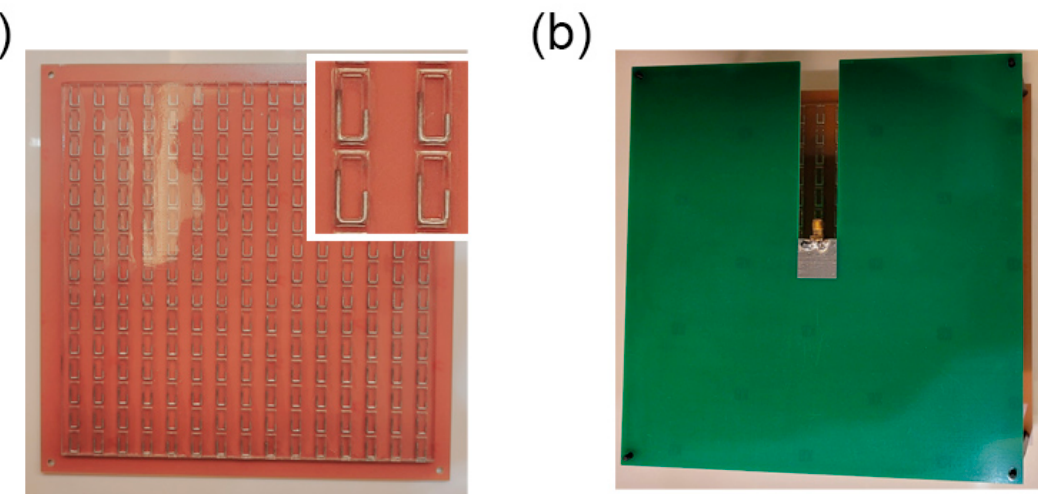
Figure 4. The fabricated metasurface antenna sample photograph. ( a ) Photograph of the liquid-metal metasurface sample as well as its enlarged figure of the element. ( b ) The assembled metasurface antenna fed by a micro-strip antenna.